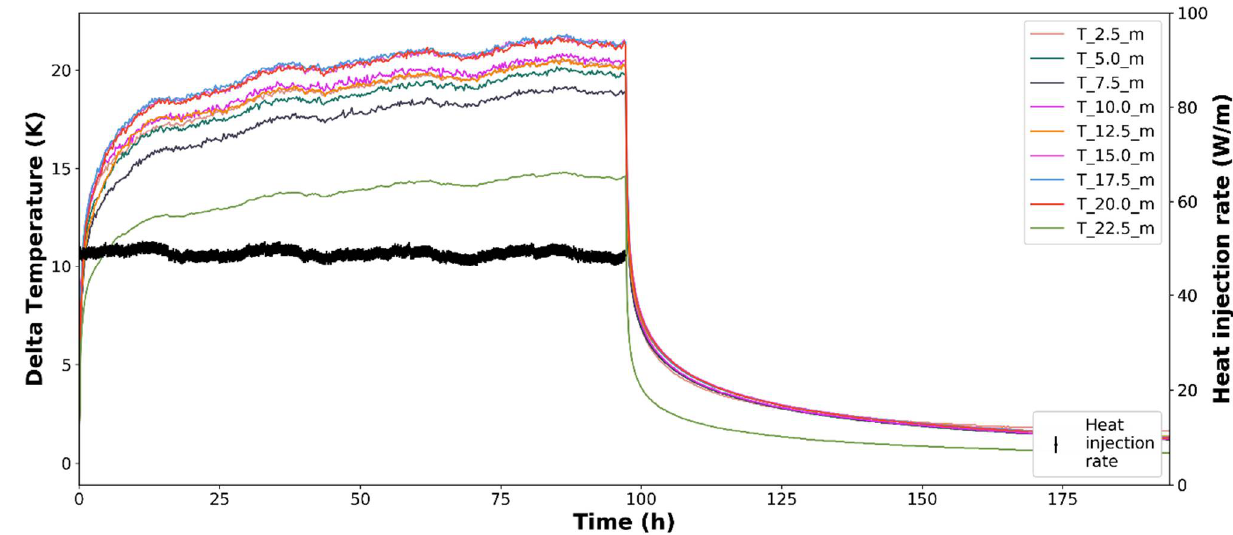
Figure 6. Results of the constant-heat-injection TRT with heating cable in the 1-U BHE.